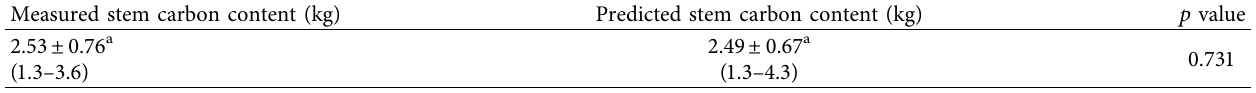
Table 5: Measured and predicted stem carbon content of Rhizophora mucronata